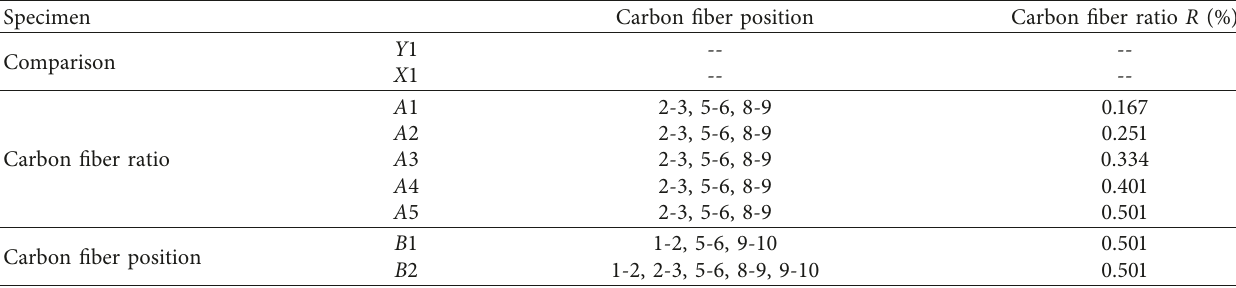
Table 1: Design parameters of the specimens.